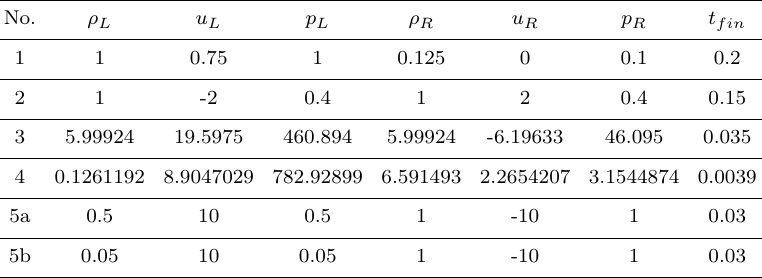
Table 1. Data for the Riemann problem